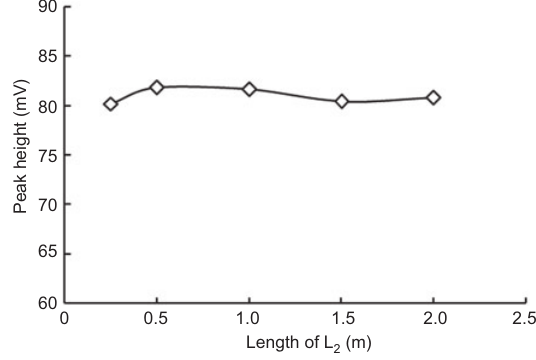
Figure 5 Effect of reaction coil (L